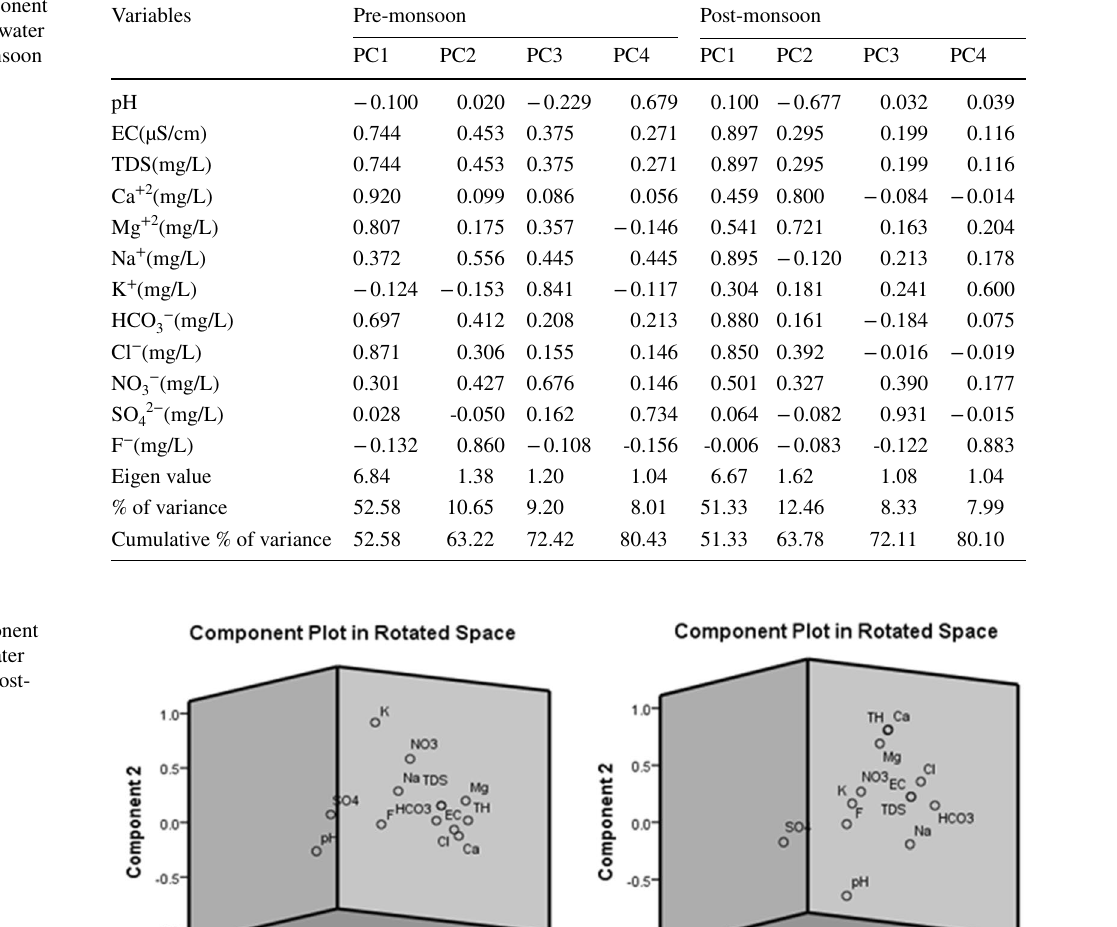
Table 5 Principal Component (PC) analysis on groundwater data in pre and post monsoon season